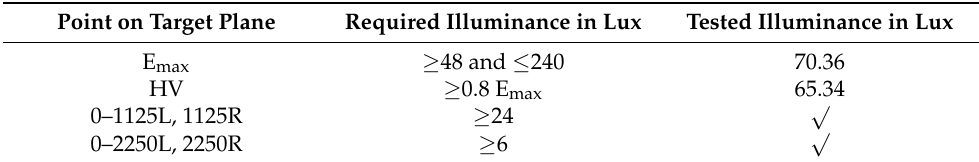
Table 4. Tested illuminance values of high beam on the target plane.